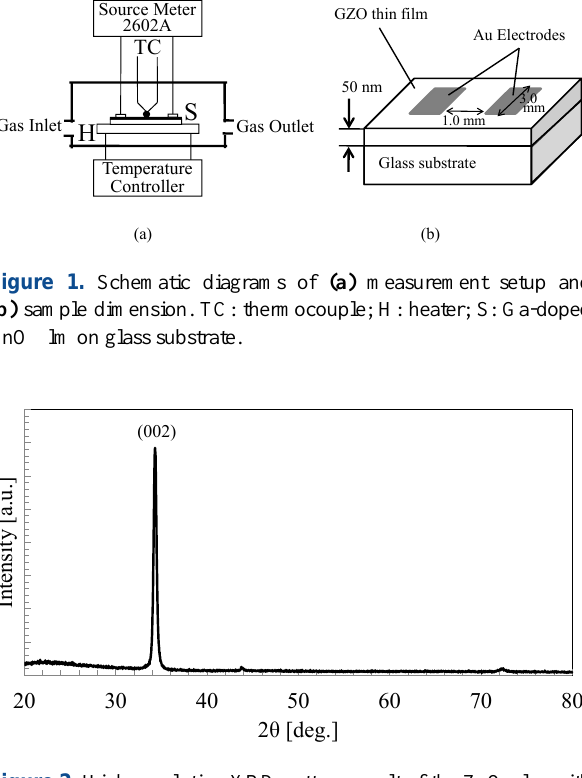
Figure 2. High resolution XRD pattern result of the ZnO film with 50 nm thickness. 2 Figure 2. High-resolution XRD pattern result of the ZnO film with 50nm thickness.